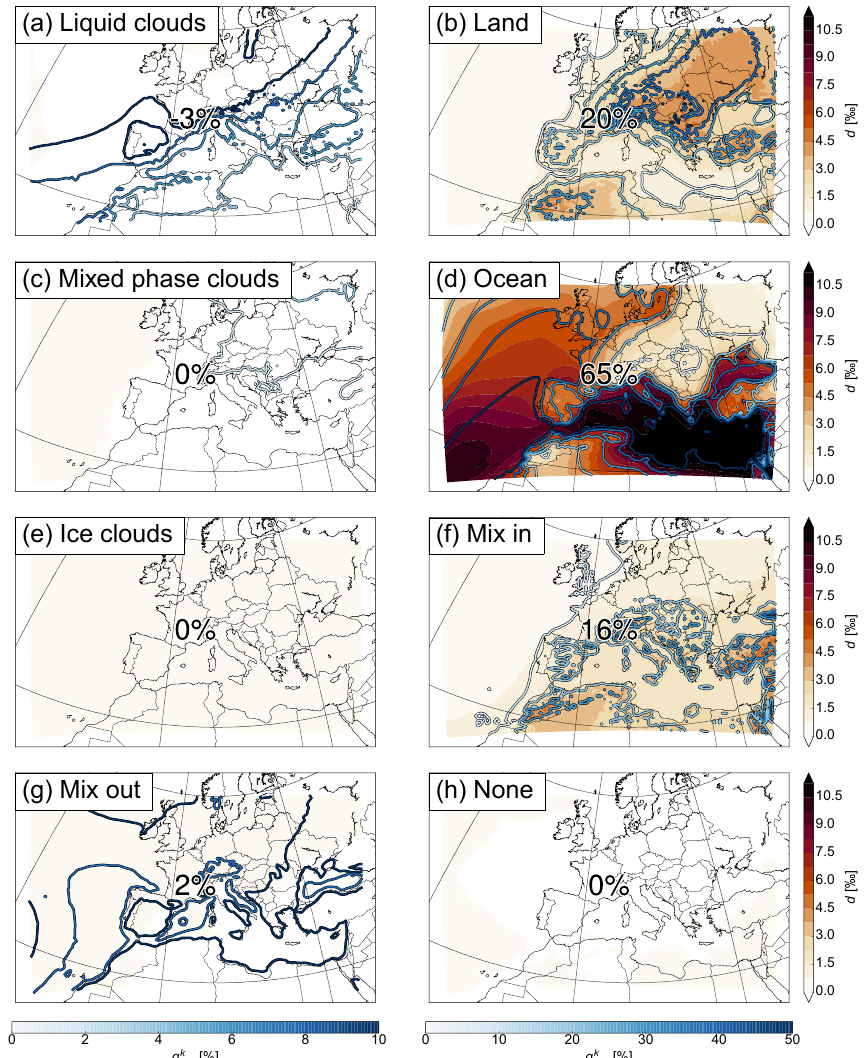
Figure 9. Contributions of the processes to (cid:49)d in Fig. 7f. The numbers show the mean contribution of each process and the contours show q k exp (see Eqs. 10 and 11) in %. Note the different colour scales for q k exp between the left- and right-hand sides.